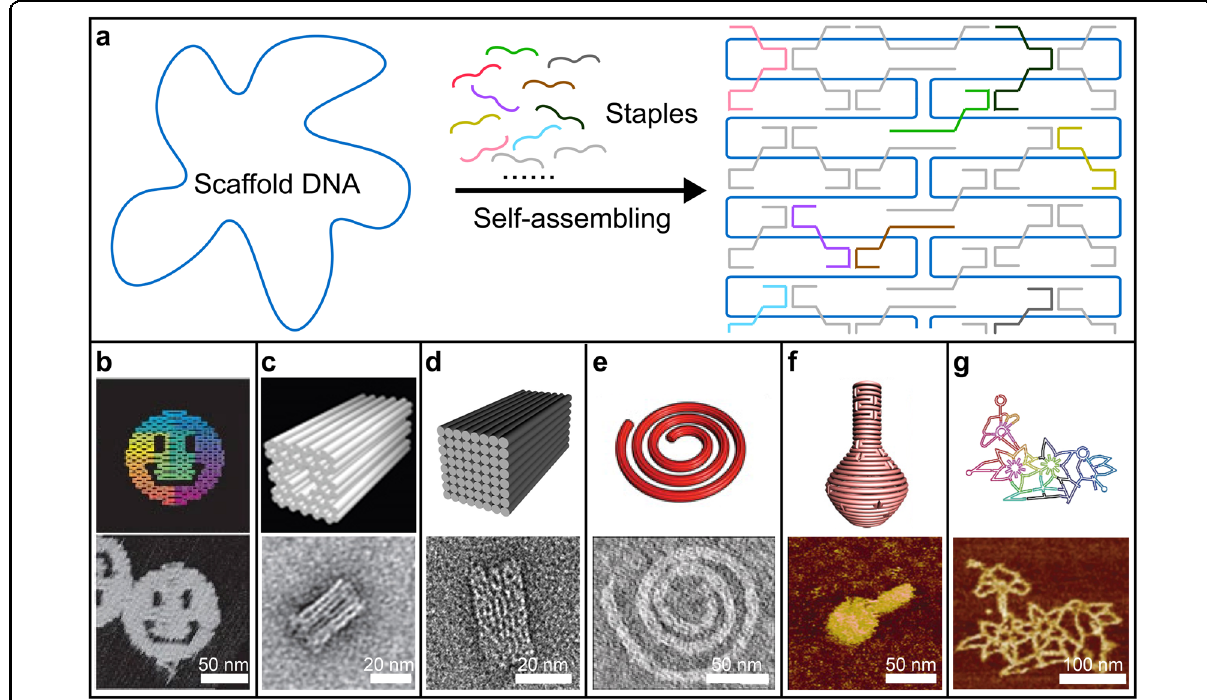
Fig. 1 DNA origami technology for the construction of 2D and 3D DNA nanostructures. a Schematic illustration of the assembly of DNA origami structures. A long single-stranded scaffold DNA (blue) is folded by a set of short staples (colored) into a prescribed shape. b DNA origami smiley face. (Reproduced with permission 3 , Copyright 2006, Macmillan Publishing Ltd.). c Square nut constructed from a honeycomb DNA lattice. (Reproduced with permission 8 , Copyright 2009, Macmillan Publishing Ltd.). d Solid block constructed from a square lattice. (Reproduced with permission 9 , Copyright 2009, American Chemical Society). e A curved 6-helix bundle. (Reproduced with permission 11 , Copyright 2009, AAAS). f A DNA nano fl ask constructed from concentric rings. (Reproduced with permission 12 , Copyright 2011, AAAS). g A fl ower-and-bird image constructed from multiarmed DNA junctions. (Reproduced with permission 15 , Copyright 2015, Macmillan Publishing